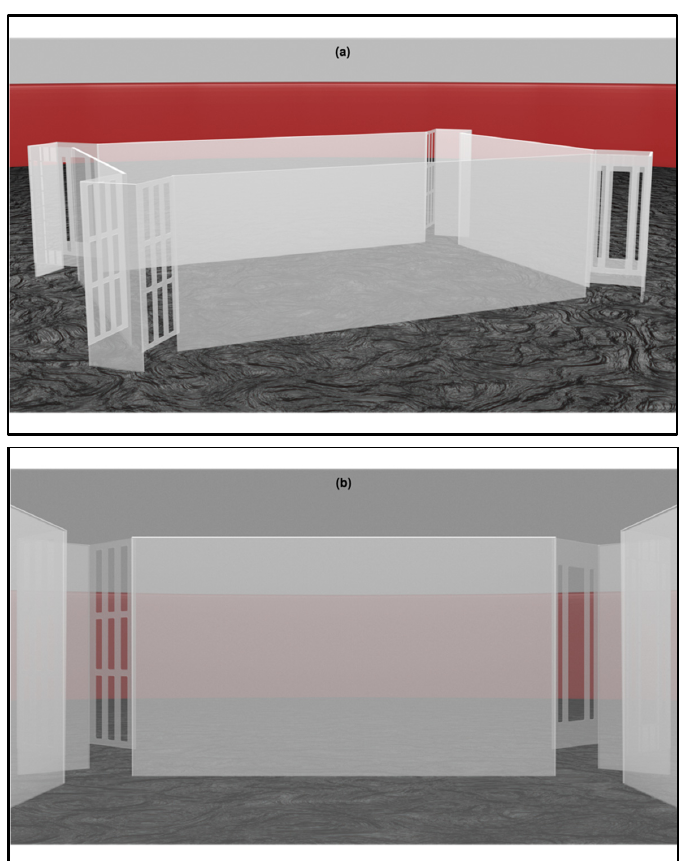
Figure 3. The figure shows the rectangular transparent arena adapted for the nonvisual rewarded exit task ( a ). Four corridors were placed at the corners – two with a large central slit that fish could exit through (correct ‐ geometry diagonal corners) and the other two with smaller slits that fish could not swim through ( b ).